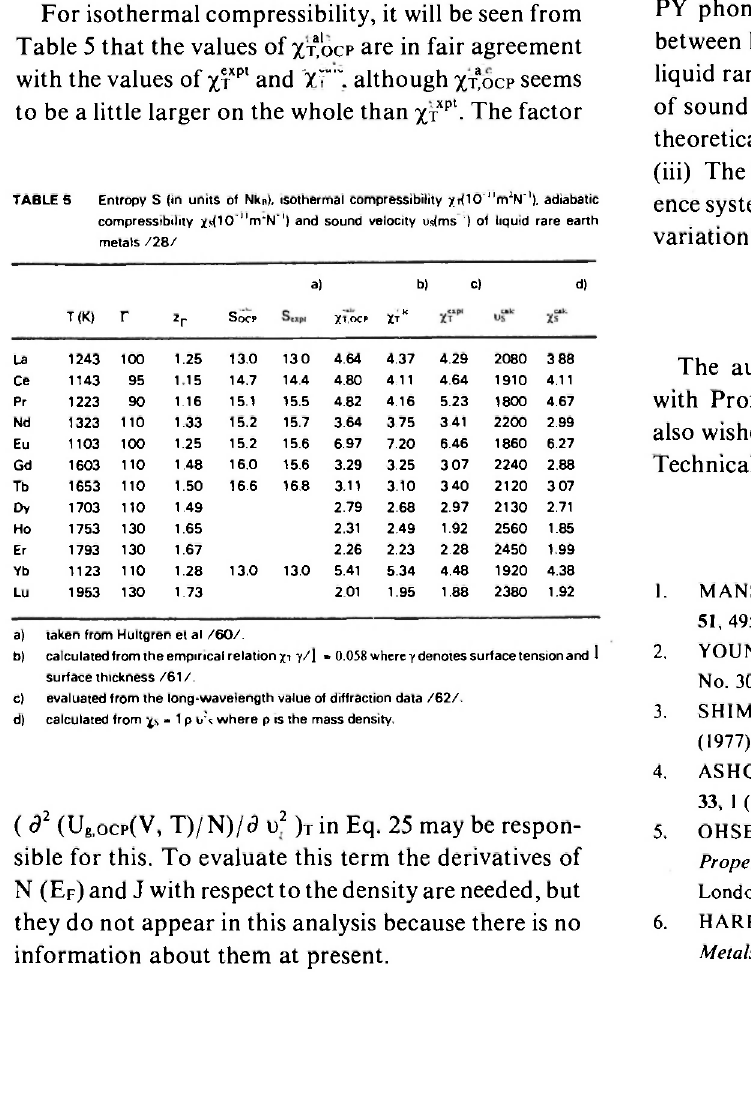
Entropv S (in units of Nk B >, isothermal compressibility χι<10 "m 2 N"'). adiabatic